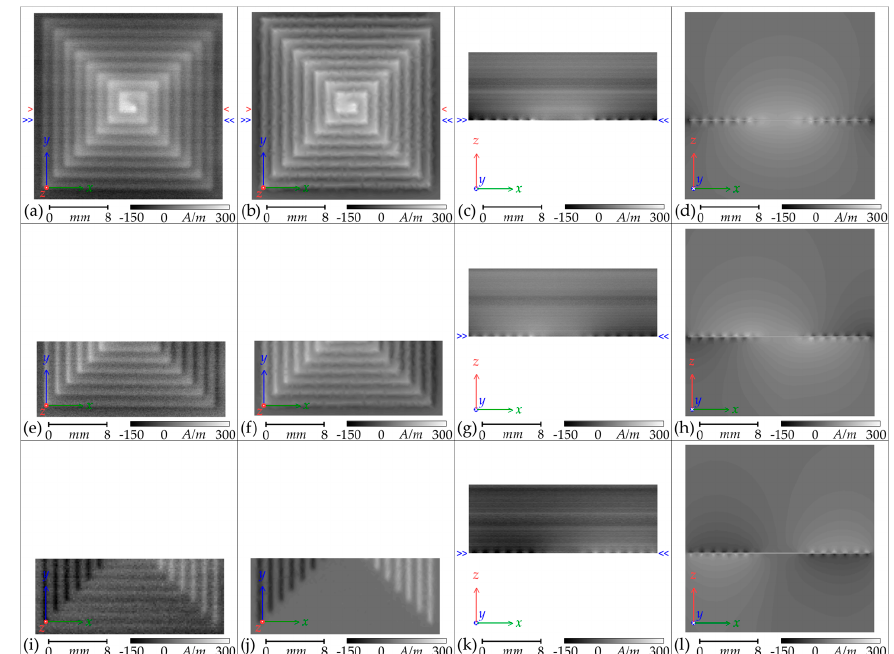
Figure 7. Greyscale maps of the H amplitudes of the manufactured Square planar coil, energized to draw 0.40 A ± 0.01 A (Columns 1 and 3), alongside the equivalent maps calculated by ANSYS ® finite-element modelling (Columns 2 and 4): ( a – d ) H ( z ) ; ( e – h ) H ( 45 ) ; ( i – l ) H ( x ) . Columns 1 and 2 are planar xy - maps and Columns 3 and 4 are cross-sectional xz -maps along the transect marked by blue double-chevrons. The transect marked by red single-chevrons indicates the path of the H ( z ) amplitude plot presented in Figure 9.